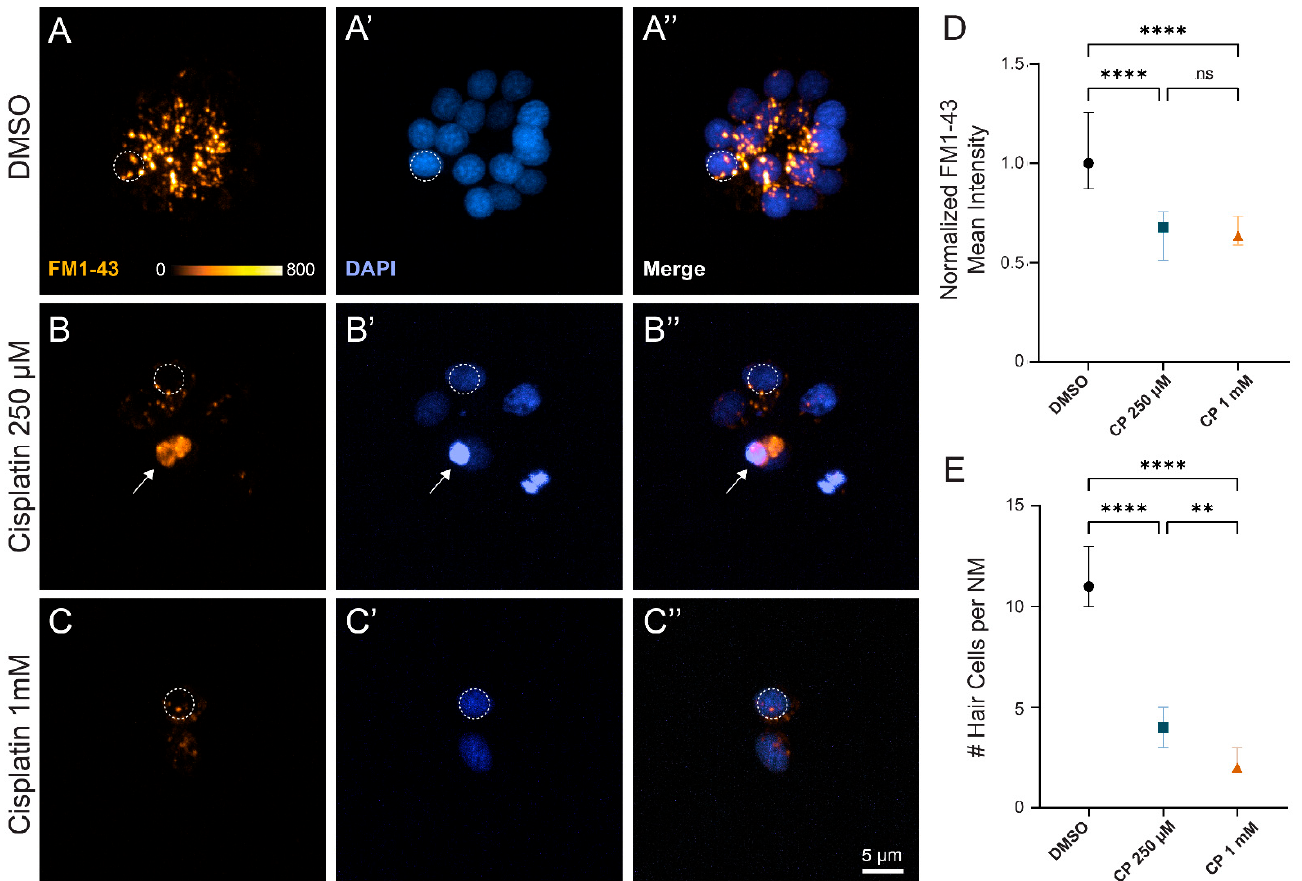
Figure 5. Surviving neuromast hair cells after cisplatin treatment demonstrate impaired mecha- notransduction. ( A – C ) Maximum-intensity projections of confocal images show wildtype zebrafish neuromasts after 2 h treatment with 0.1% DMSO ( A ), 250 µM cisplatin ( B ), and 1 mM cisplatin ( C ) followed by a 24 h recovery in EM. Dotted circles exemplify 4 µm region of interest used to measure mean FM1-43 intensity. Arrow indicates non-viable hair cell that was not included in analysis ( B ). Mean hair cell FM1-43 intensity (normalized to control) demonstrates decreased mechanotransduc- tion among cisplatin-treated fish compared to those exposed to vehicle control (( D ), **** p < 0.0001, Kruskal–Wallis test). Post hoc analysis with Dunnett’s multiple comparisons test failed to detect significant changes in FM1-43 uptake between moderate and high dose cisplatin (( D ), ns > 0.9999). Cisplatin demonstrates a dose-dependent increase in hair cell loss (( E ), **** p < 0.0001, ** p = 0.0069; Dunnett’s multiple comparisons test). Median values with corresponding 95% confidence intervals shown for both FM1-43 uptake and hair cell counts. n = 3–4 fish (2–3 neuromasts per fish). N = 3 trials.